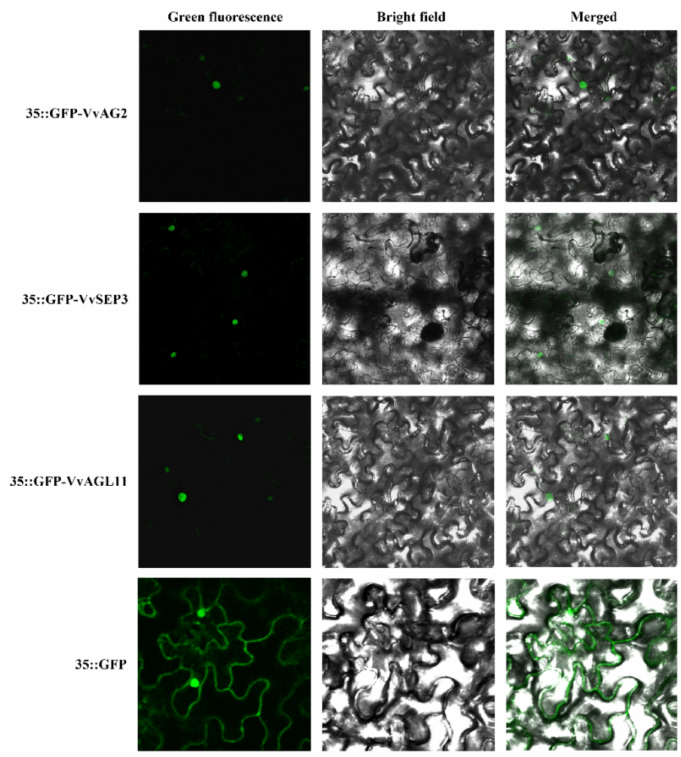
Figure 5. Subcellular localization of the VvAG2, VvSEP3 and VvSEP3 proteins in N. benthamiana . GFP-AG2, GFP-SEP3, GFP-AGL11 are located in the nucleus of Nicotiana benthamiana , GFP alone is located in the whole cell. Fluorescence (the left column), bright field (the middle column) and combined images (the right column) were obtained by using a confocal microscope after 48 h of Agrobacterium infiltration.